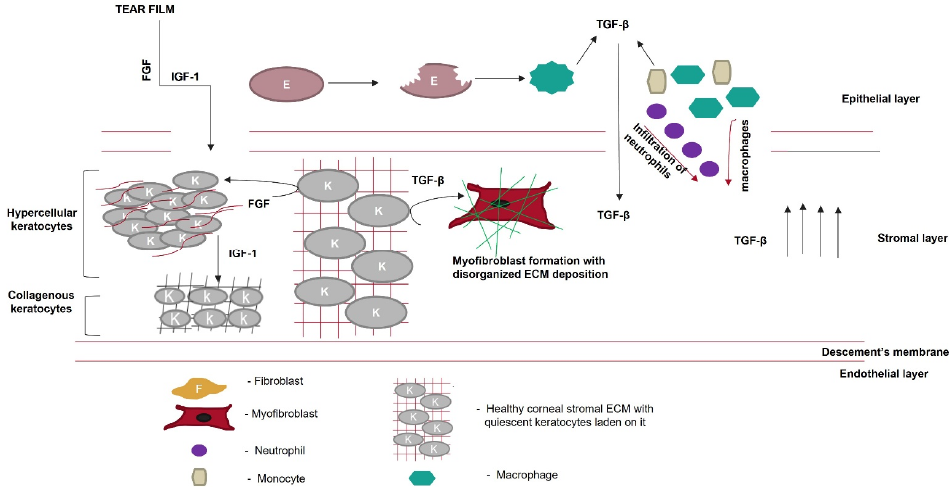
Figure 5. Role of growth factors in scar prevention. Various growth factors, such as fibroblast growth factor (FGF) or insulin-like growth factor (IGF-1), are secreted from the tear film. These growth factors cross the disrupted Bowman’s membrane to reach the corneal stromal layer. FGF converts keratocytes to hypercellular keratocytes. IGF-1 converts hypercellular keratocytes to colla- genous keratocytes, which secrete ECM components similarly to the native cornea. Meanwhile, in the epithelial layer, after wounding, epithelial cells undergo apoptosis, and the apoptotic epithelial cells release TGF- β . Neutrophils, macrophages, and monocytes, which migrate from the epithelial layer to the stromal layer, secrete TGF- β , thereby increasing its local concentration. Keratocytes in the presence of TGF- β are converted to myofibroblasts, which disrupt the highly organized fibrillar arrangement of the corneal ECM.